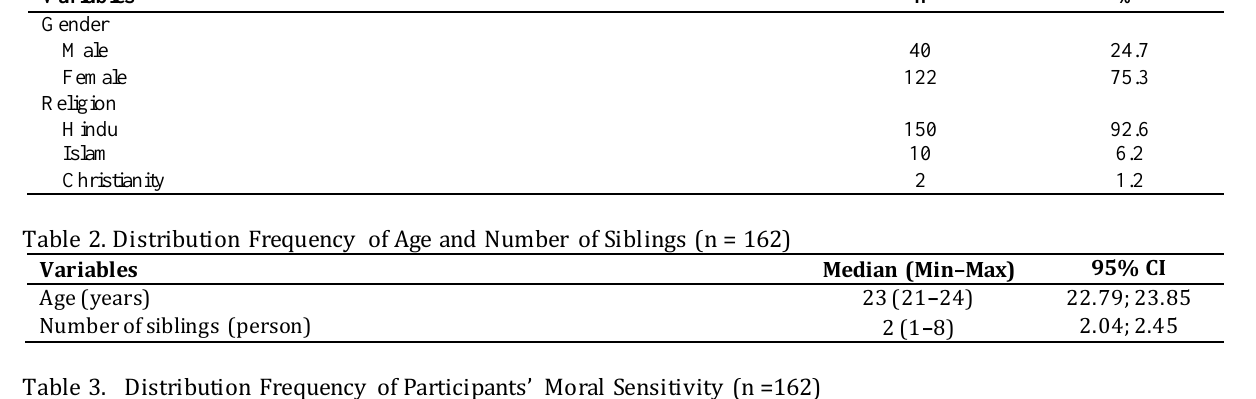
Table 1. Participants’ Demographic Characteristics based on Gender and Religion (n = 162) Variables